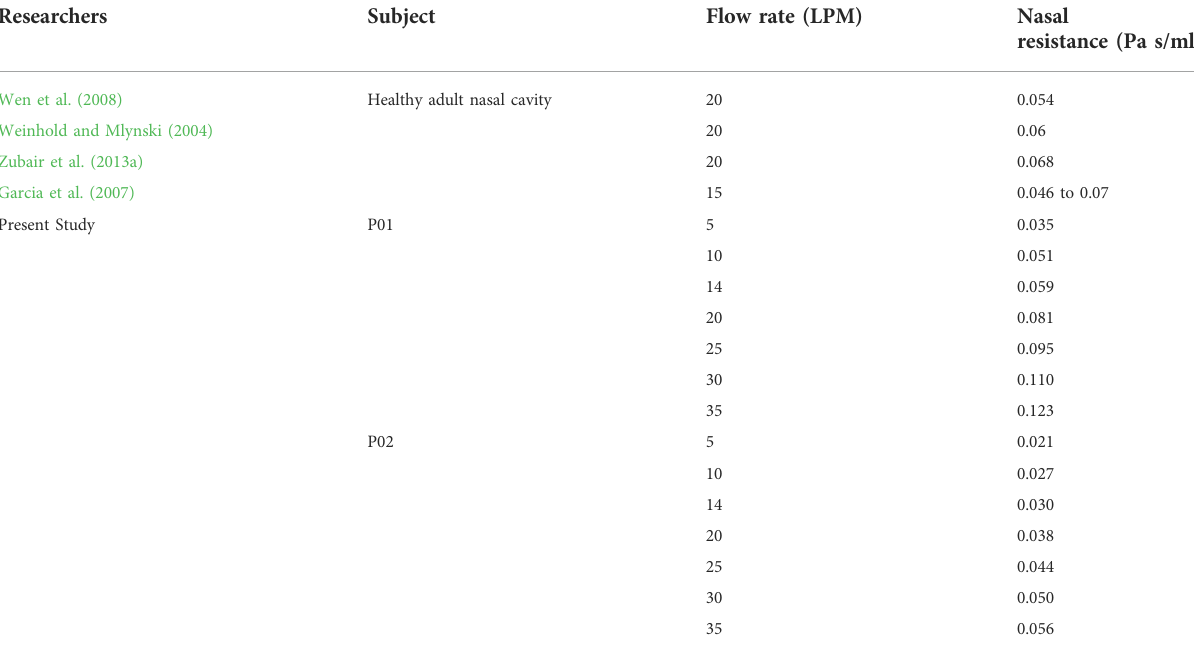
TABLE 7 Nasal resistance across the nasal cavity.